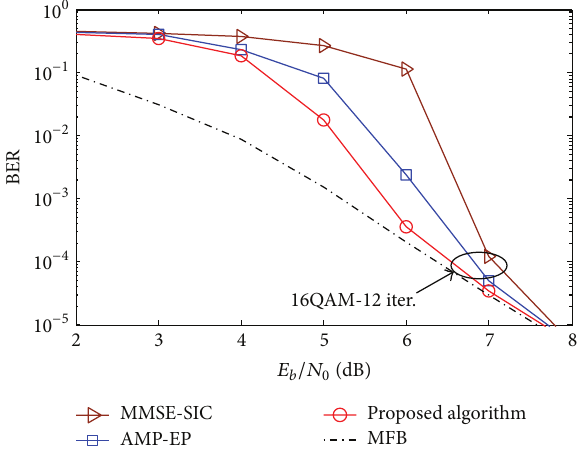
Proposed algorithm Figure 11: BER performance comparison for different detection algorithms in a 64 × 64 MIMO system, with 16QAM modulation and ITU-EVA